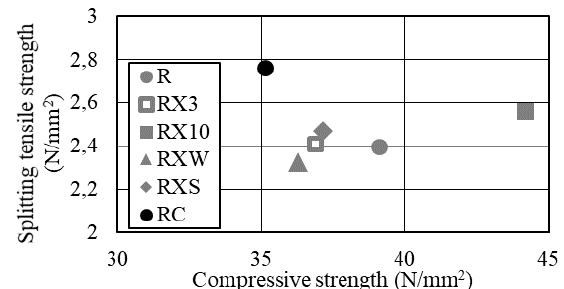
Figure 5. Compressive strength and splitting tensile strength.